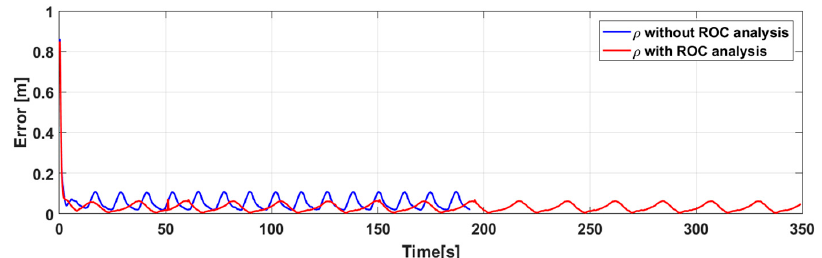
Figure 10. Quadratic control errors.